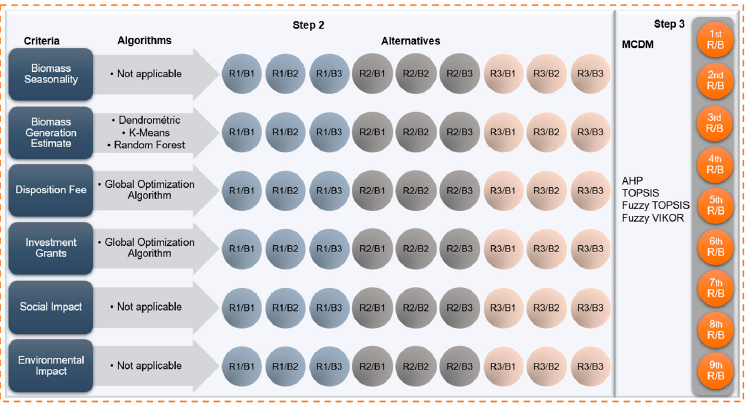
Figure 3. Detailed illustration of steps 2 and 3 in Phase 1. Note. R1/B1, R2/B1, R3/B1 refer to the ratio between region and type of biomass analyzed.